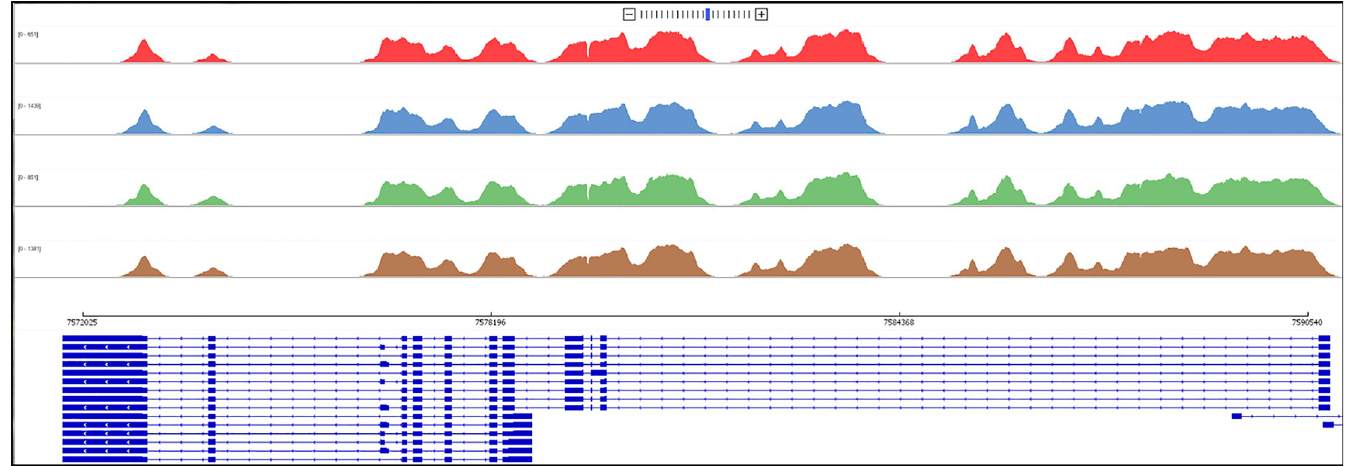
Fig 1. Coverage map across TP53 gene targeting all coding exons and intron 1, 2, 4, 5, 6, 7, and 8. In intron 1, coverage dips below an average of 10x in two small regions.